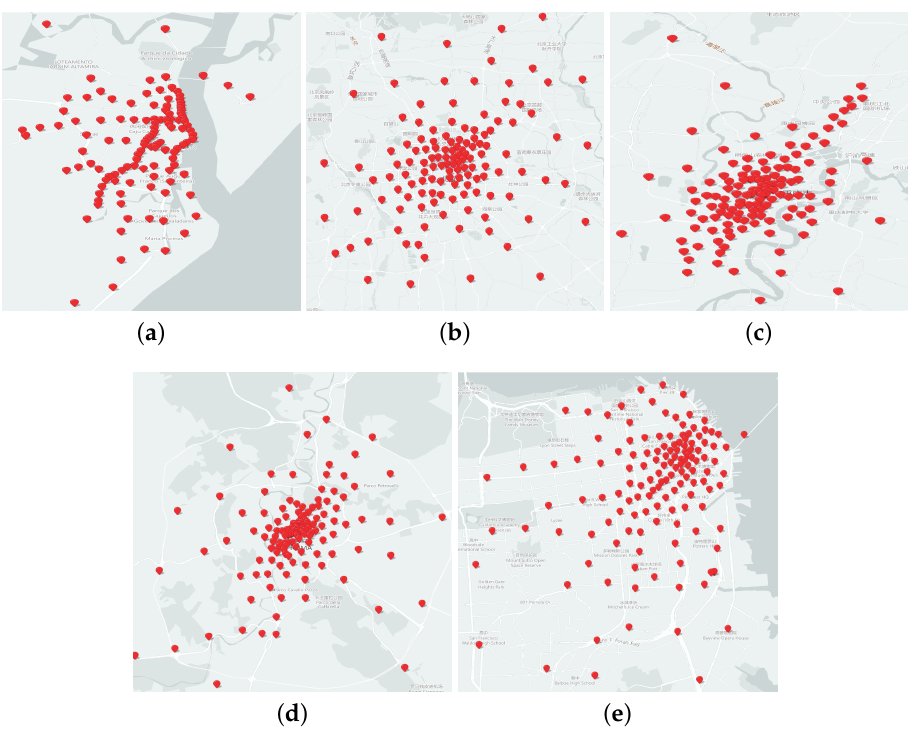
Figure 14. The urban hotspots captured by the GAK algorithm. ( a ) Aracaju; ( b ) Beijing; ( c ) Chongqing; ( d ) Roma; ( e ) San Francisco.